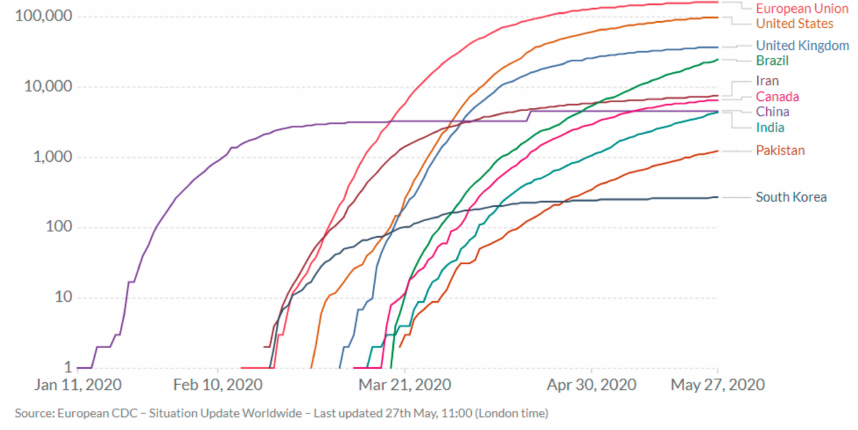
Figure 2. Total confirmed deaths due to COVID-19 on log scale (as on 27 May 2020)